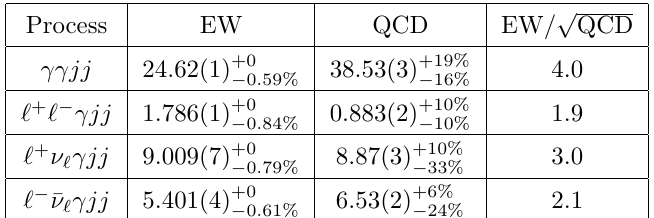
Table 3 . EW and QCD event numbers for di(cid:11)erent cuts calculated at NLO with luminosity L = 1 fb (cid:0) 1 . For the other cuts, default values are used.